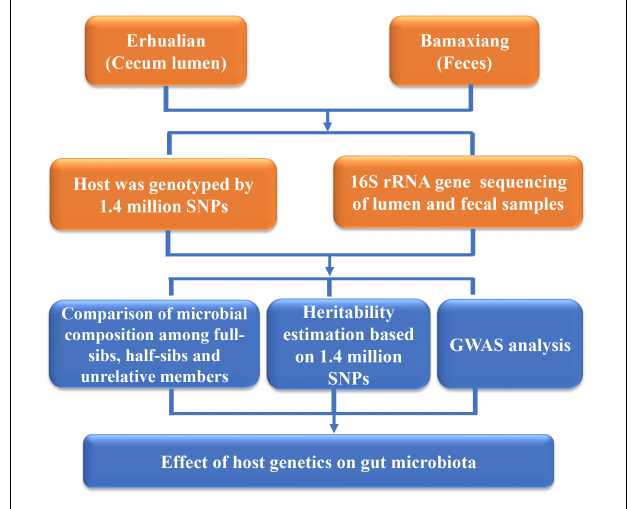
FIGURE 1 | Flowchart depicting the experimental design for studying the host genetic effect on gut microbial composition in pigs.